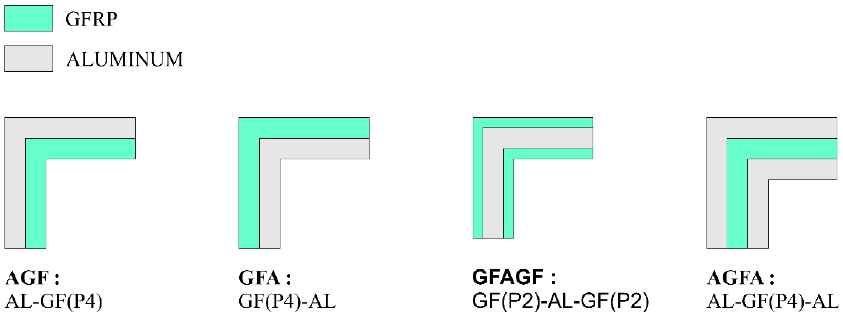
Figure 3. Schematic representation of the stacking sequence.